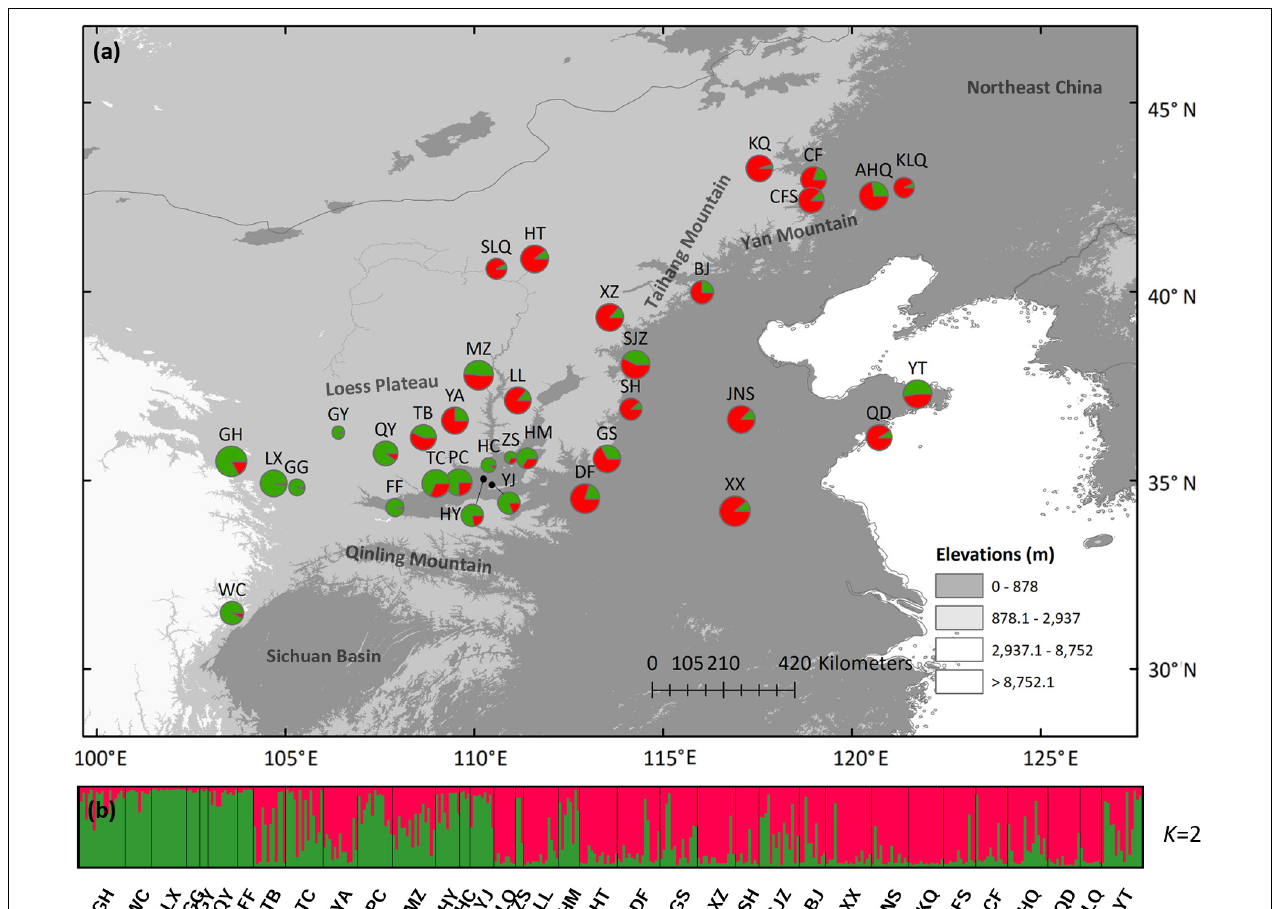
FIGURE 4 | (a) Color-coded grouping of the 35 Speranskia tuberculata populations according to the most likely K = 2 inferred from STRUCTURE analysis. (b) Histogram of the STRUCTURE assignment test at K = 2.